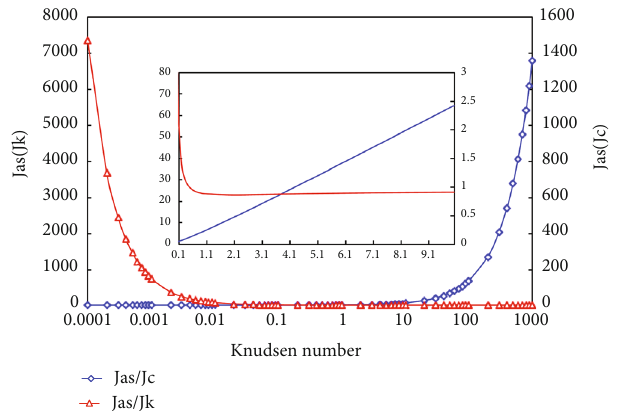
Figure 8: The bulk-gas transport capacity curve with di ff erent Knudsen